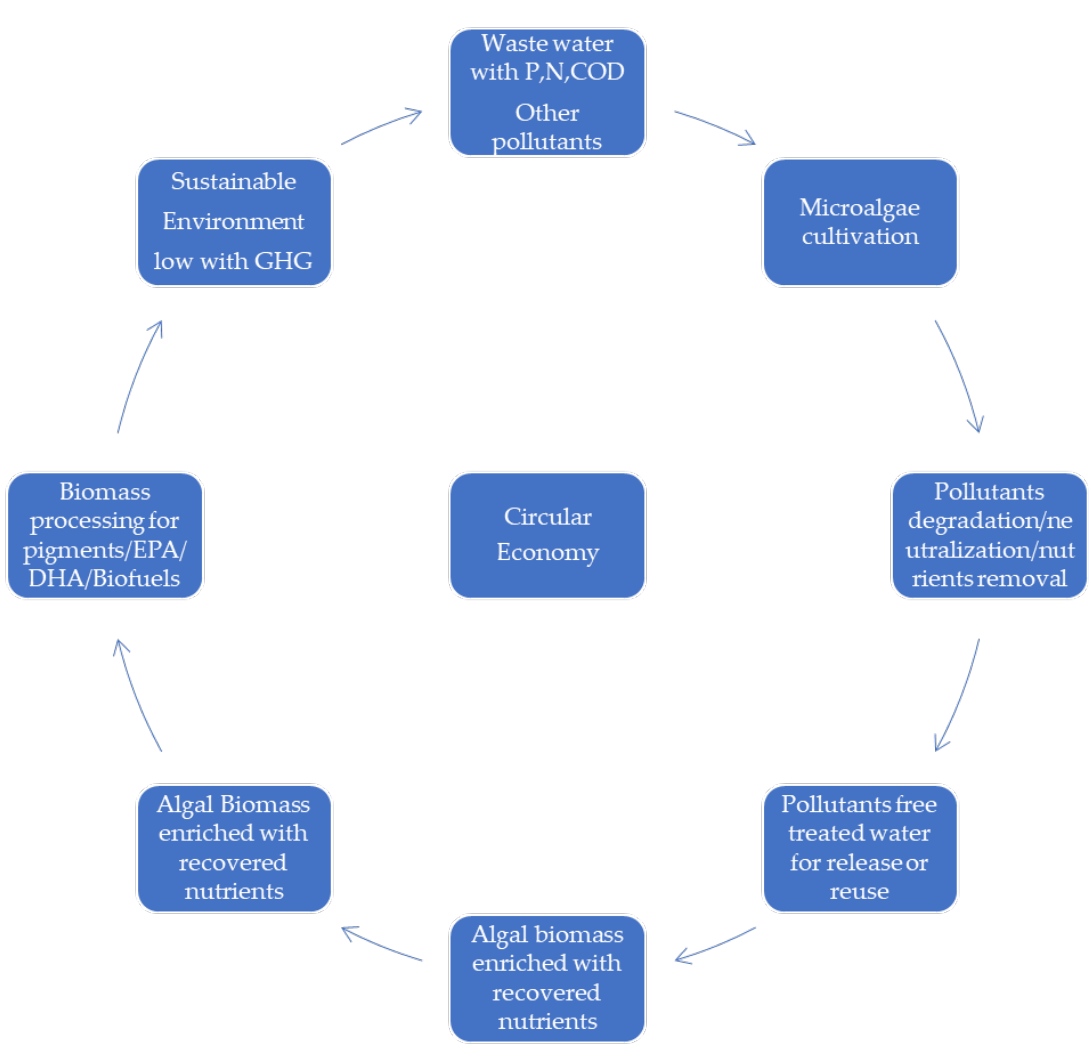
Figure 3. Integration of wastewater treatment with microalgal cultivation and resource recovery in a circular bioeconomy perspective.